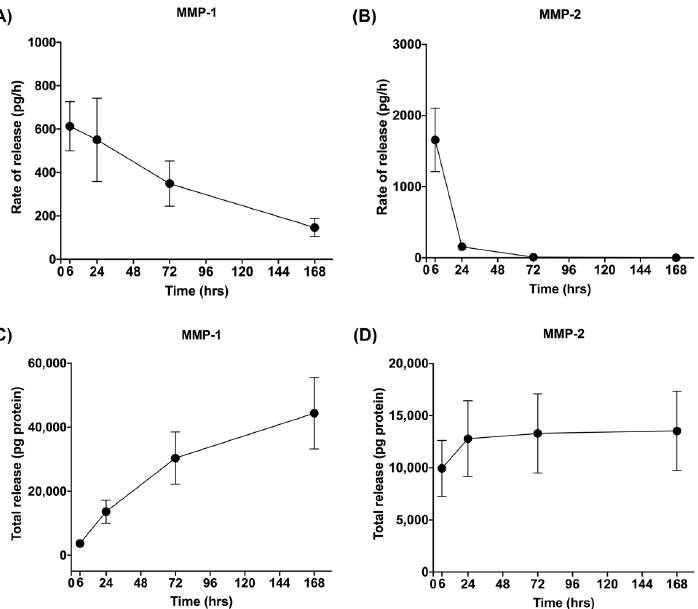
Figure 4. Rate of release and total release of matrix metalloproteinases (MMPs). The figure shows the rate of release and total release of the tested matrix metalloproteinases (MMPs) from the L-PRF membrane up to 168 h. Panels ( A , C ) display MMP-1 and ( B , D ) MMP-2 for rate of release and total release, respectively. Mean ± SEM is displayed at each time